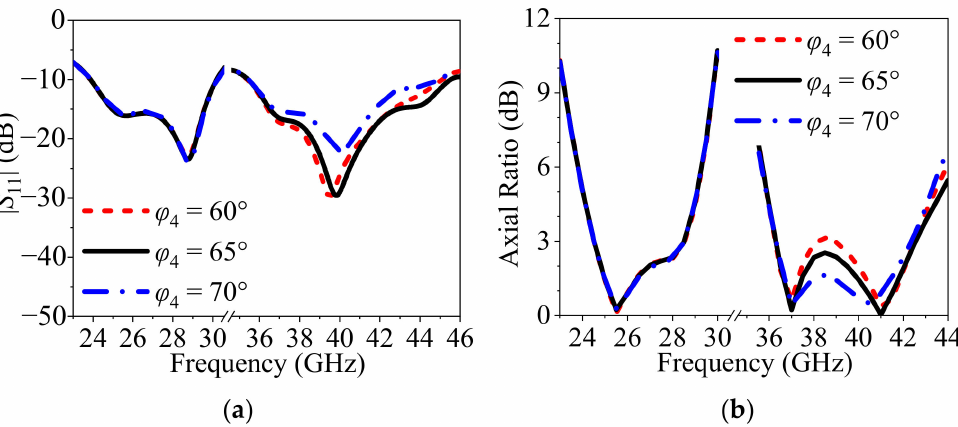
Figure 8. Simulated results of the dual-band CP DRA at different radian ϕ 4 of Slot 3: ( a ) Reflection coefficients; ( b )